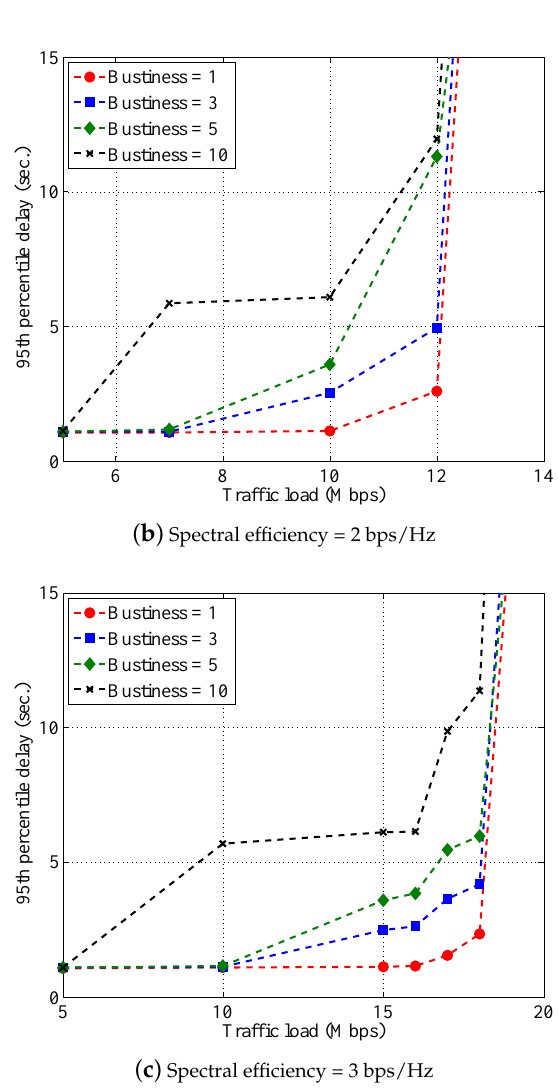
Figure 9. The 95th percentile delay according to the traffic load (Mbps) when burstiness varies from 1–10 (RBDC).